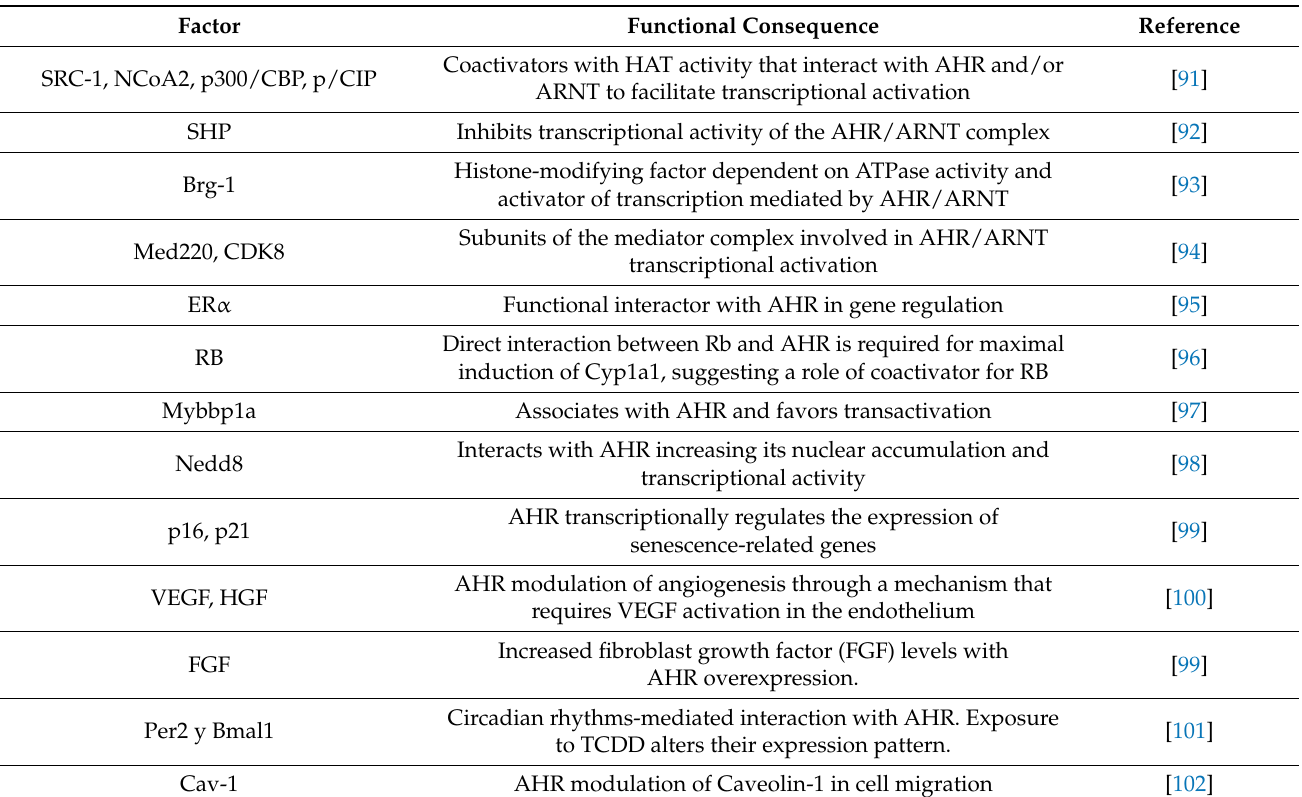
Table 1. List of other AHR-interacting